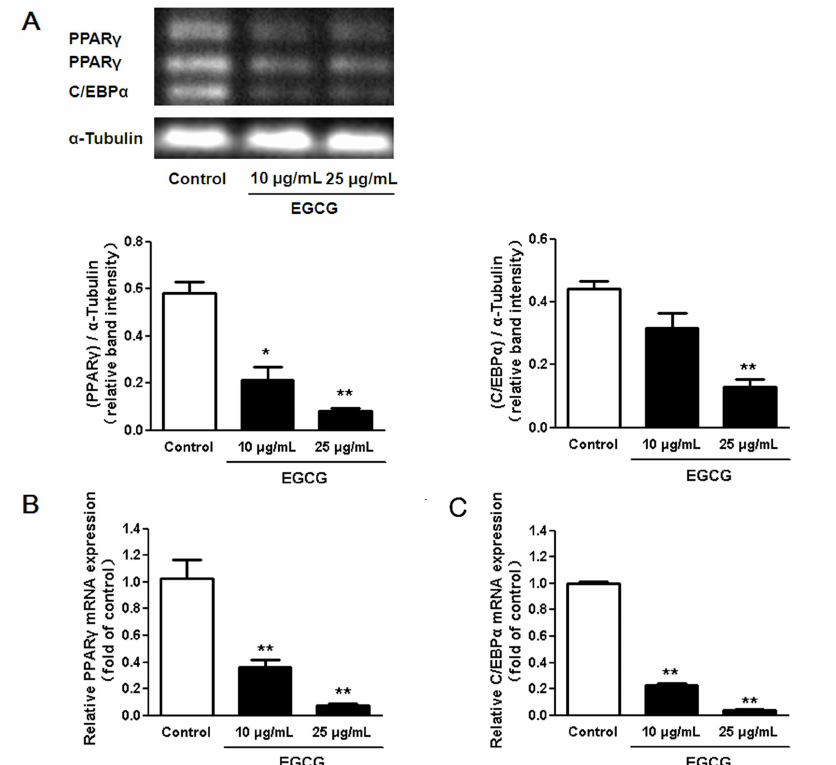
Figure 3. Effects of ( ´ )-Epigallocatechin-3-gallate (EGCG) on the expression of adipogenic transcription factors during adipogenesis. ( A ) EGCG decreased both C/EBP α and Peroxisome proliferator-activated receptor γ (PPAR γ ) protein expression levels in a dose-dependent manner. Changes in expression of PPAR γ ( B ) and C/EBP α ( C ) in differentiated 3T3-L1 adipocytes treated with EGCG as analyzed by quantitative real-time polymerase chain reaction (PCR). Results were normalized to the expression of α -tubulin and are expressed as relative mRNA level compared with the average expression in cells incubated without EGCG. The error bars represent the standard deviation (SD) ( n = 3); * p < 0.05, ** p < 0.01 vs. the